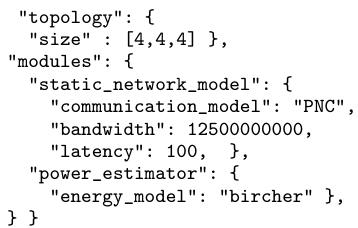
Figure 2: Time-space diagram of events ordered in different locations and their associated